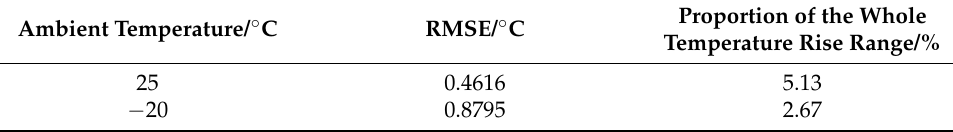
Table 1. The simulation results of the cell thermal model. Ambient Temperature/ ◦ C